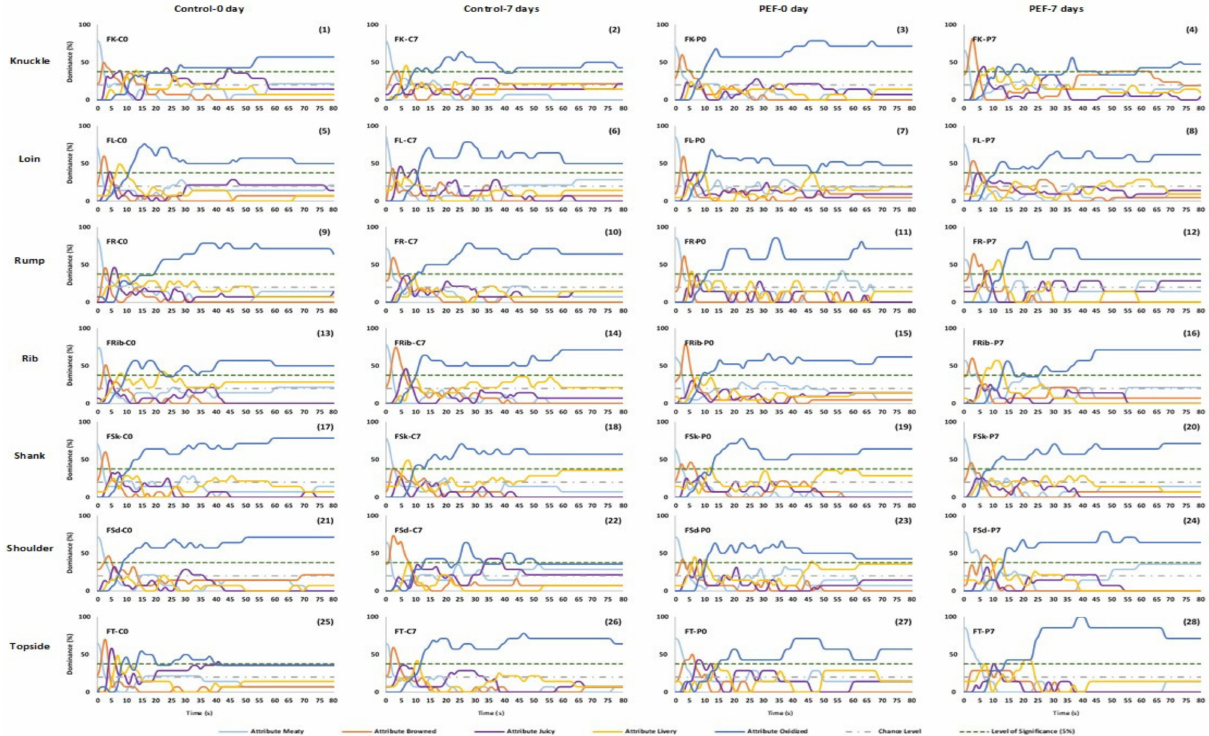
Figure 2. TDS curves of non-PEF and PEF treated cooked frozen-thawed lamb meat cuts (C: control; P: PEF; 0 and 7: number of storage